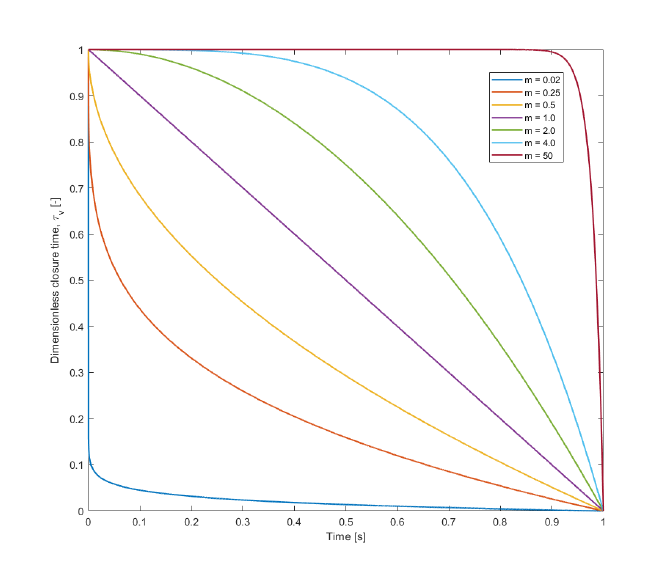
Figure 2. Effect of m on τ v with t c =